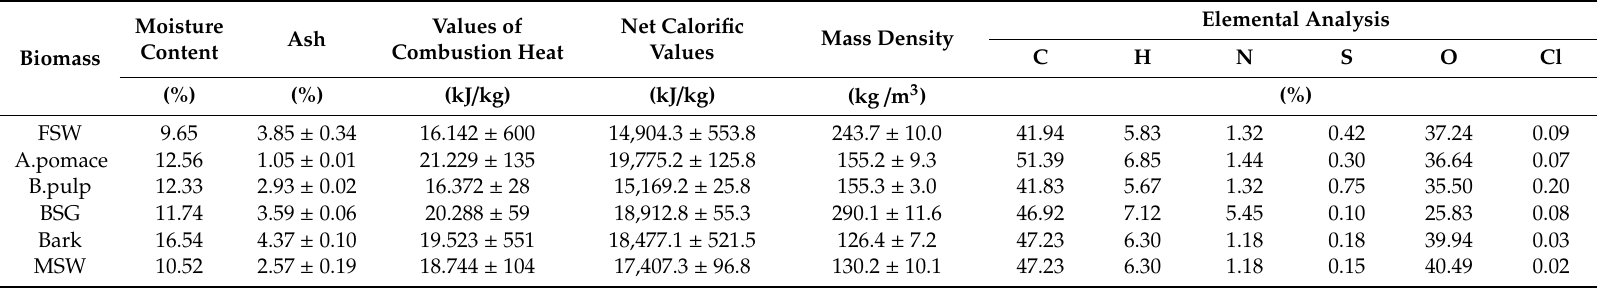
Table 1. Compositional and elemental analysis of biomass, expressed as average values ( ± standard deviation). FSW—flavored spirits production waste